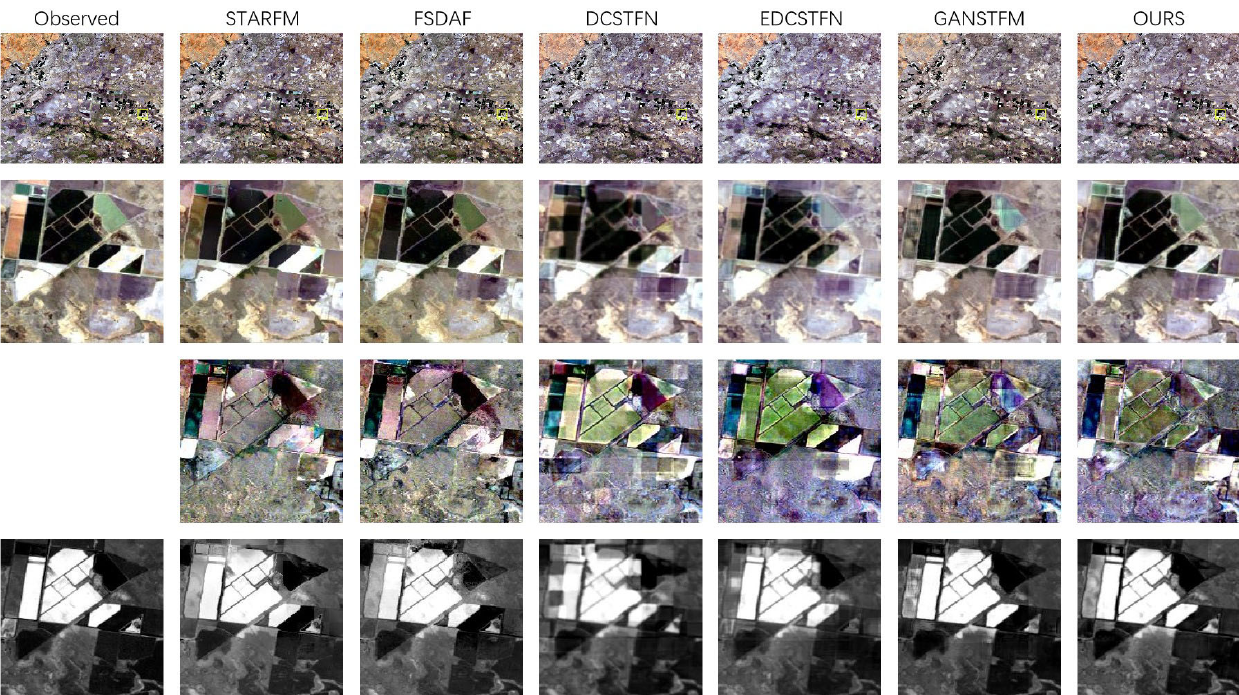
Figure 11. Local magnification of the LGC dataset shows the